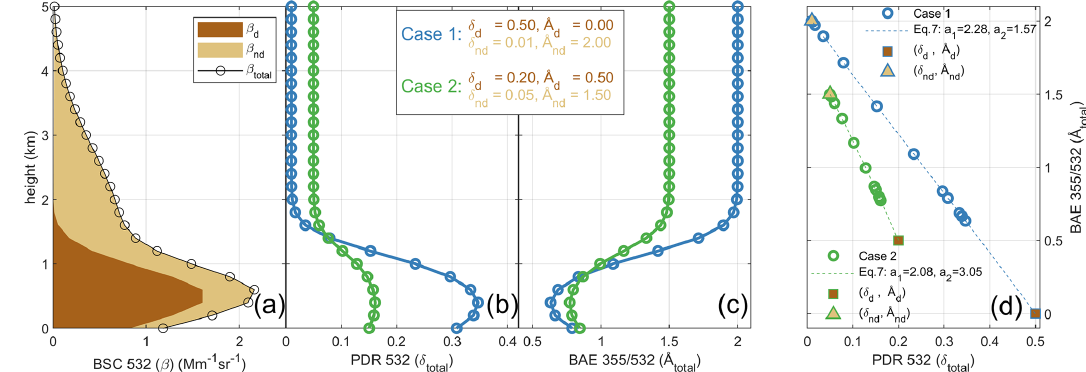
Figure 1. (a) Synthetic vertical profile of the total particle backscatter coefficient ( β total ) at 532nm; the shares of depolarizing ( β d ) and non-depolarizing ( β nd ) particles are given by dark brown and light brown areas. Synthetic profiles of (b) the particle linear depolarization ratio (PDR, δ total ) at 532nm and (c) the backscatter-related Ångström exponent (BAE, Å total ) between 355 and 532nm, under two groups of initial values (case 1 in blue and case 2 in green) of the depolarization ratio ( δ ) and the BAE of depolarizing (d) and non-depolarizing (nd) particles ( δ d , δ nd , Å d , Å nd ; values given in the legend). (d) Scatter plot of δ total and Å total for two synthetic cases. The dashed fitting line of each case is determined by Eq. (7) with parameters ( a 1 and a 2 ) given. The boundary points (dark brown squares and light brown triangles) are defined by the initial values (shown in the legend in b–c ). Open circles present each